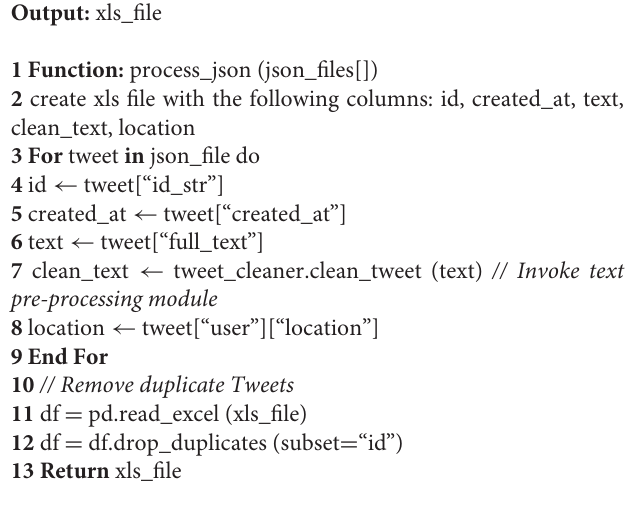
Algorithm 1 | The JSON parser